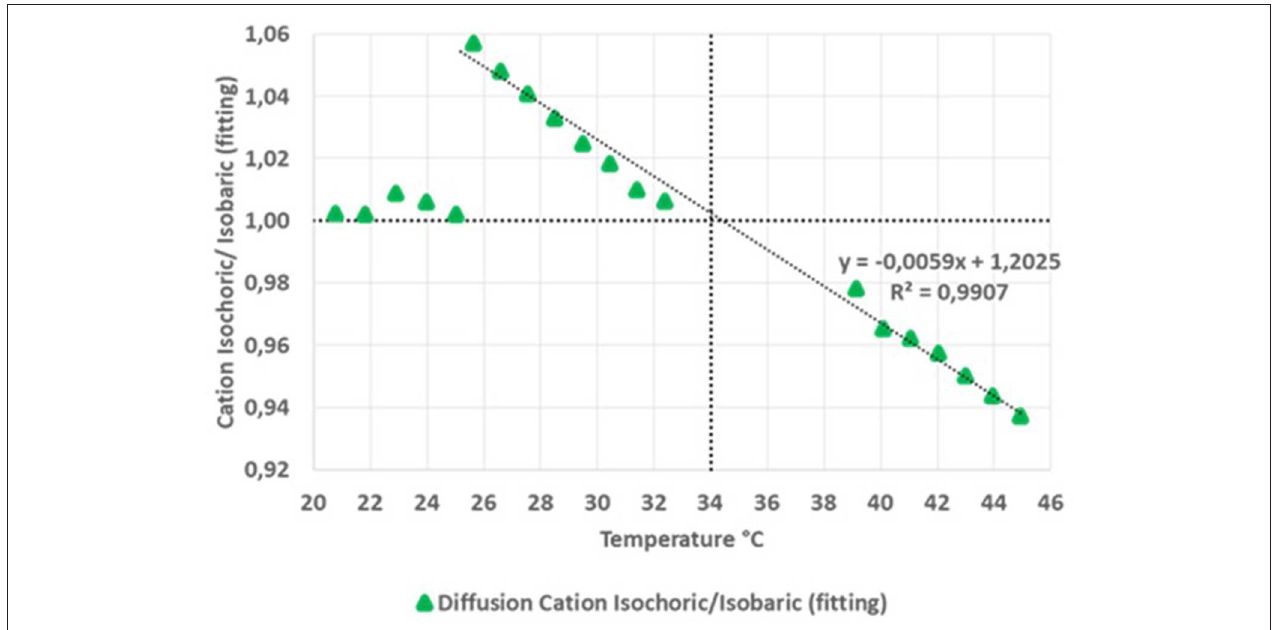
FIGURE 11 | Relative cation’s self-diffusion coefficients vs. temperature in positive, negative, and null pressure regimes. (Reprinted from Silva et al., 2018).